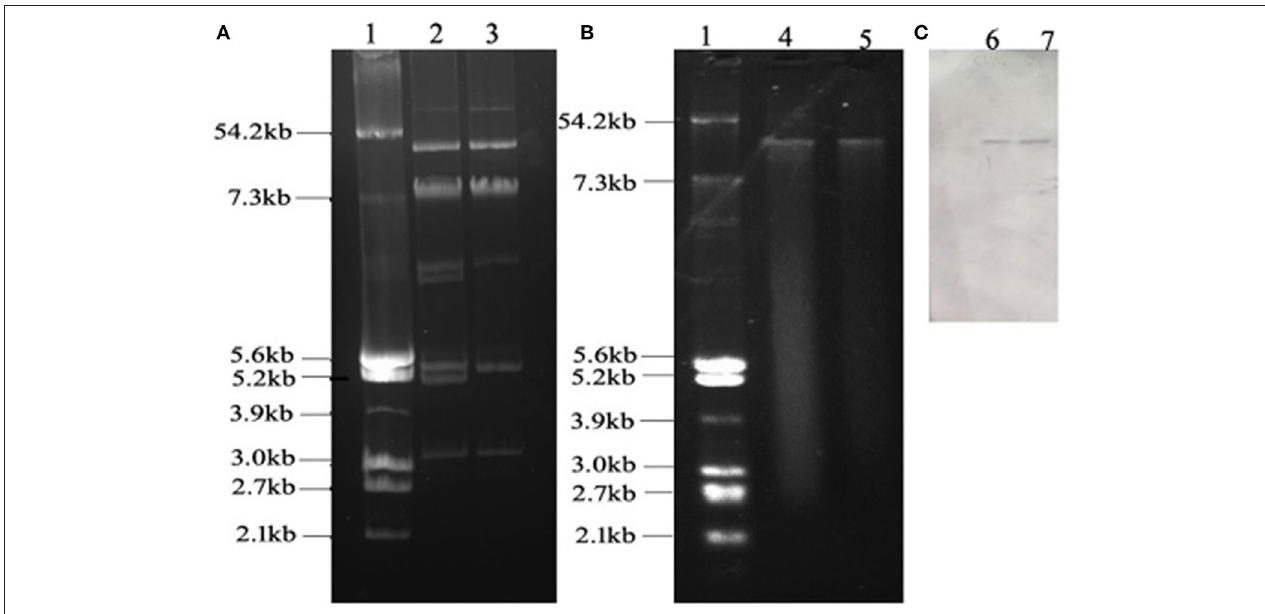
FIGURE 1 | (A) Agarose electrophoresis of plasmids from E. coli strains W4 and 5Y. (B) Agarose electrophoresis of plasmids from transconjugant E. coli TW4 and T5Y. (C) Southern blot of plasmids from W4 and 5Y and labeled tet (M) fragment. Lane 1, reference plasmid DNAs of E. coli V517; lane 2, plasmids from W4; lane 3, plasmids from 5Y; lane 4, plasmid from TW4; lane 5, plasmid from T5Y; lane 6, southern blot, plasmids from W4; lane 7, southern blot, plasmids from 5Y.